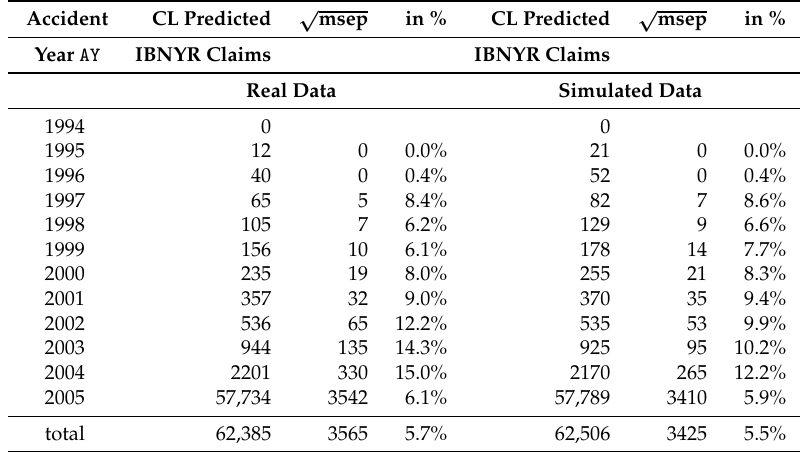
Table 6. Chain-ladder predicted numbers of incurred but not yet reported (IBNYR) claims and Mack’s √ msep for the real and the simulated